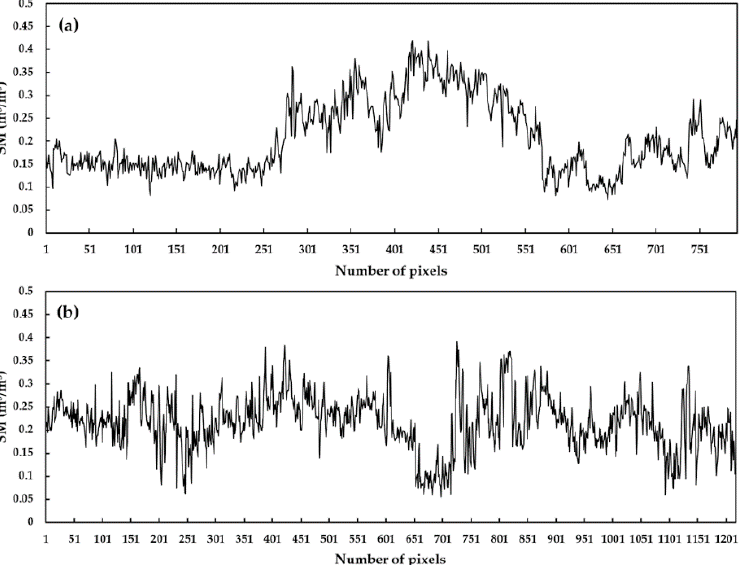
Figure 10. The SM values for the two transect lines. ( a ): Red transect line; ( b ): Black transect line.